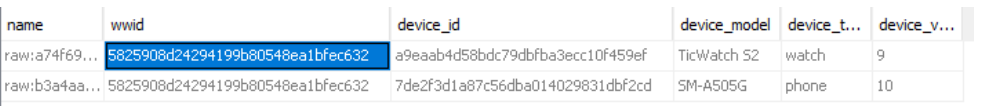
Figure 27. A record showing information about the TicWatch and the Android smartphone that was used to pair with the device.